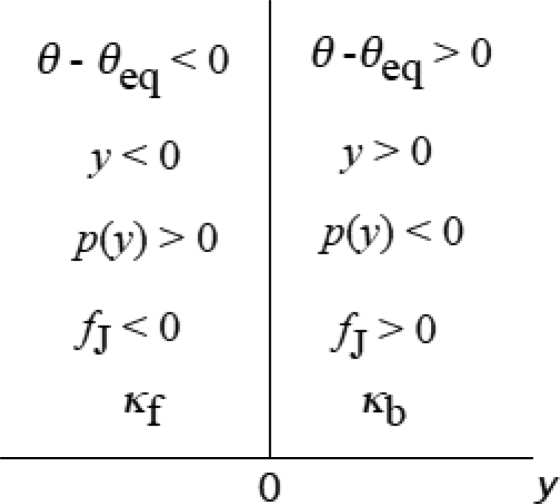
Various quantities in the domain of y = x − xeq (Eq. 3-4-1)